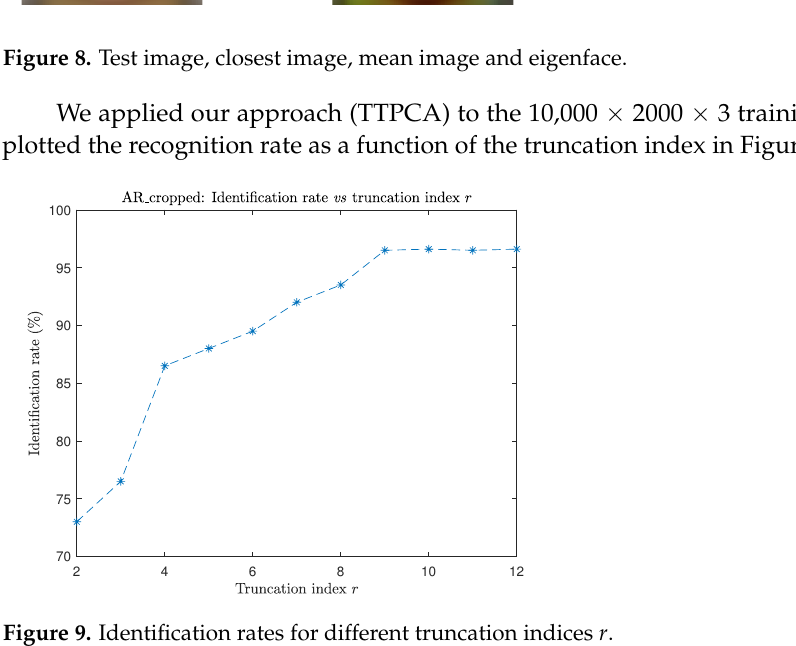
Figure 9. Identification rates for different truncation indices r